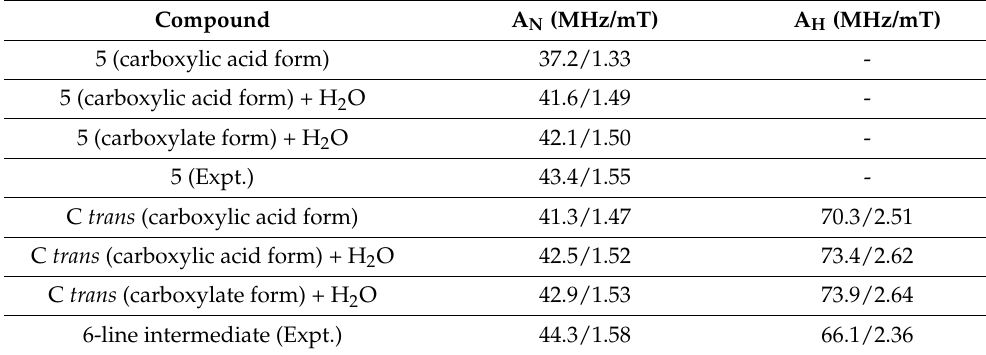
Table 5. DFT-calculated hyperfine coupling constants (hfccs, MHz/mT) and comparison to experi- mental results. The hydrogen atom under study is explicitly presented in Figure